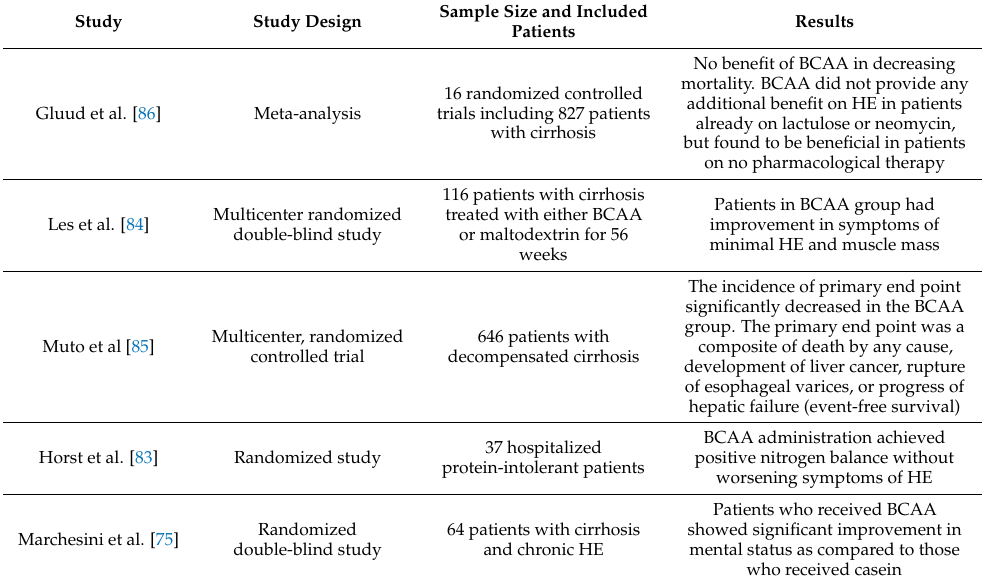
Table 2. Summary of studies on BCAA supplementation in patients with